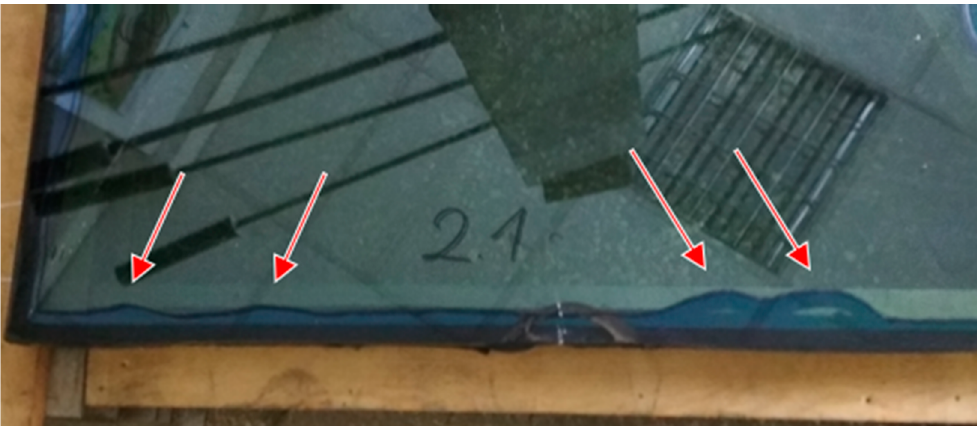
Figure 3. Examples of composite PIB seal displacement affecting the silicone-butyl connection and probably also the seal function.